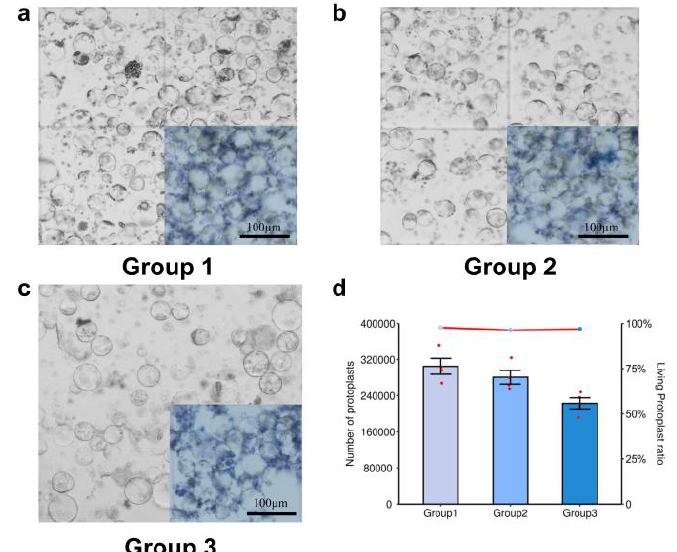
Figure 4. Microscopic examination of protoplasts treated with different concentrations of enzyme solutions. Microscopic examination of protoplasts extracted with ( a ) solution 1: 1.5% cellulase, 1.5% pectinase, 0.5% macerozyme, and 0.5% hemicellulase; ( b ) solution 2: 2.1% cellulase, 2.1% pectinase, 0.7% macerozyme, and 0.7% hemicellulase; and ( c ) solution 3: 0.9% cellulase, 0.9% pectinase, 0.3% macerozyme, and 0.3% hemicellulase. ( d ) Number and activity of protoplasts extracted with differ- ent concentrations of enzyme solutions.